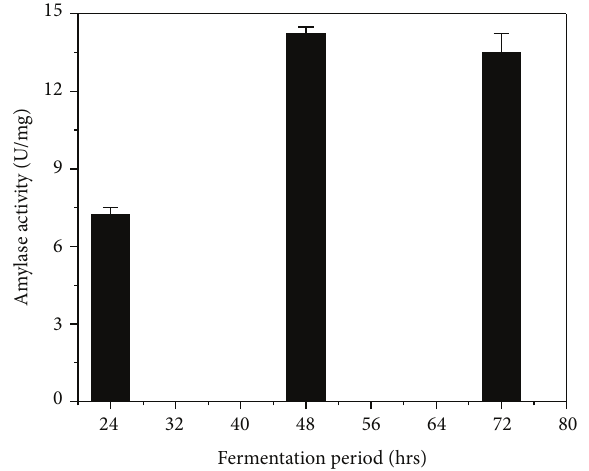
Figure 2: 𝛼 -Amylase production from solid state fermentation using B. amyloliquefaciens (MTCC 1270) and wheat bran; black column: specific activity of 𝛼 -amylase from SSF extract during different fermentation time